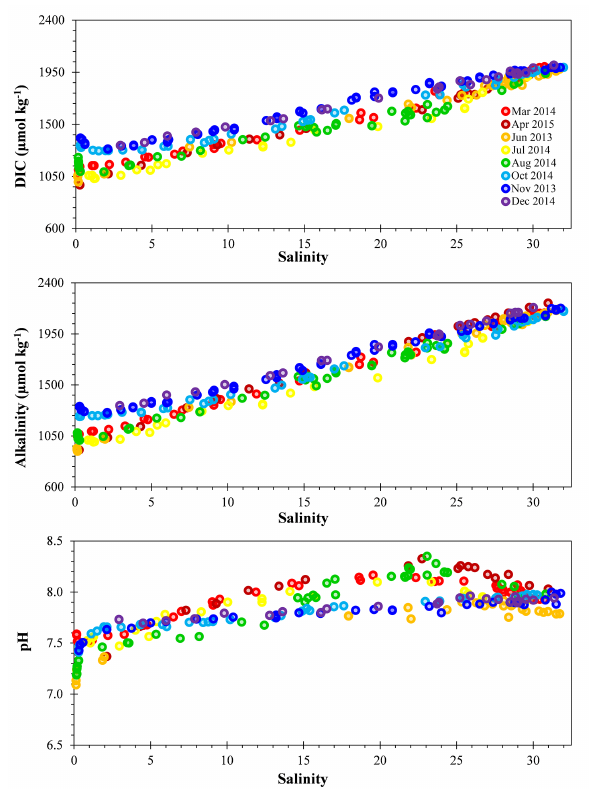
Figure 3. Salinity distributions of DIC, alkalinity, and pH in the Delaware